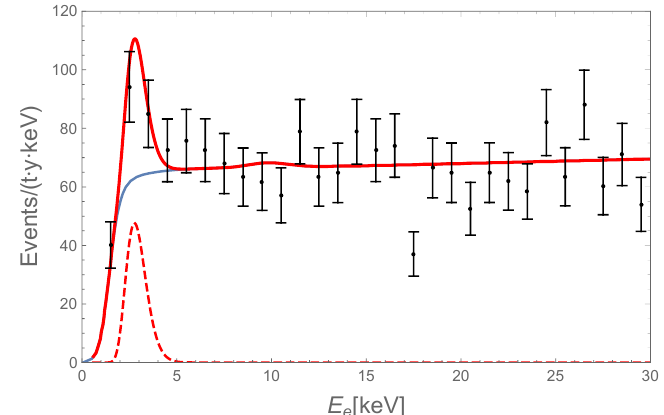
Figure 1 . The differential event rate (solid red curve) for a benchmark point, m χ α X = 3 . 59 × 10 − 3 , (cid:15) = 1 . 14 × 10 − 9 , δ = 2 . 8 keV , and m Z 0 = 10 − 4 eV . The dashed curve is the contribution of the NP signal only. The experimental data and the background blue curve are extracted from